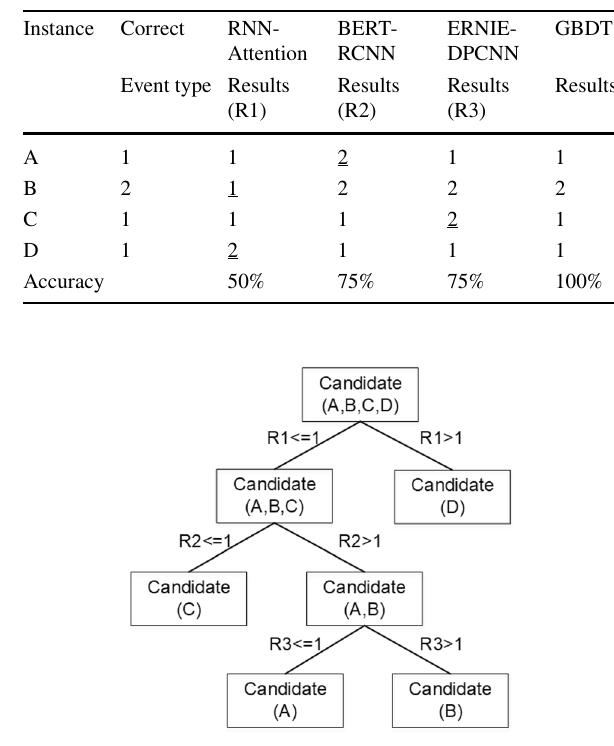
Table 3 GBDT recognition results, where “1” represents outbreak event, “2” represents activity event, and the underlined font represents recognition error